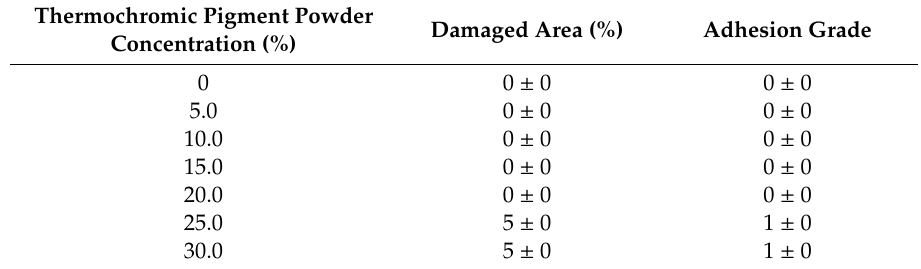
Table 5. Influence of di ff erent concentrations of the thermochromic pigment powder on the adhesion of the primer film.